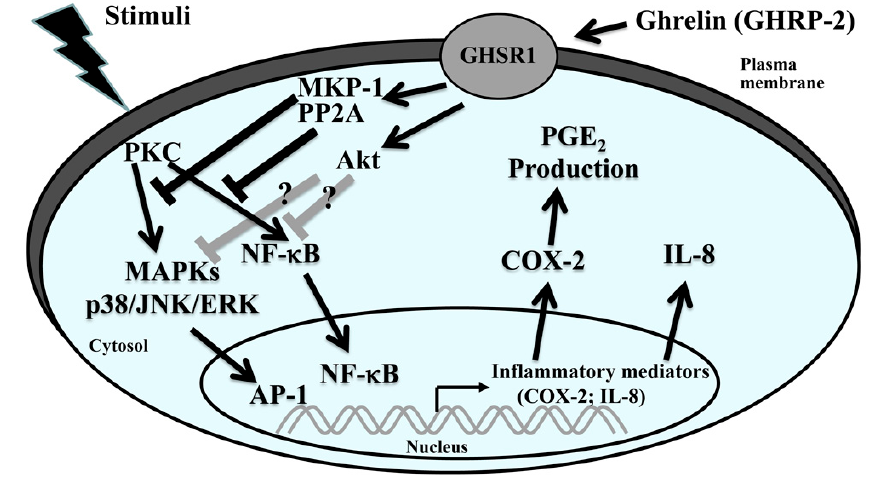
Figure 12. Outline of the PKC regulation of COX-2 and IL-8 production and the potential acting points of ghrelin (GHRP-2) in ovarian granulosa cells. PKC activates the intracellular signaling pathways, including the MAPKs (p38, JNK, ERK) as well as the NF- κ B pathways, both of which would lead to transcription of COX-2 and IL-8, and consequently mediate the output of PGE 2 and IL-8. Ghrelin (GHRP-2) may regulate MKP-1 and PPA2 to affect the PKC-mediated activation of MAPKs and NF- κ B, as well as activate the Akt pathway, and subsequently to attenuate the PKC-induced COX-2 and IL-8 transcription, resulting in reduction of COX-2 and IL-8 protein levels as well as PGE 2 and IL-8 secretion.